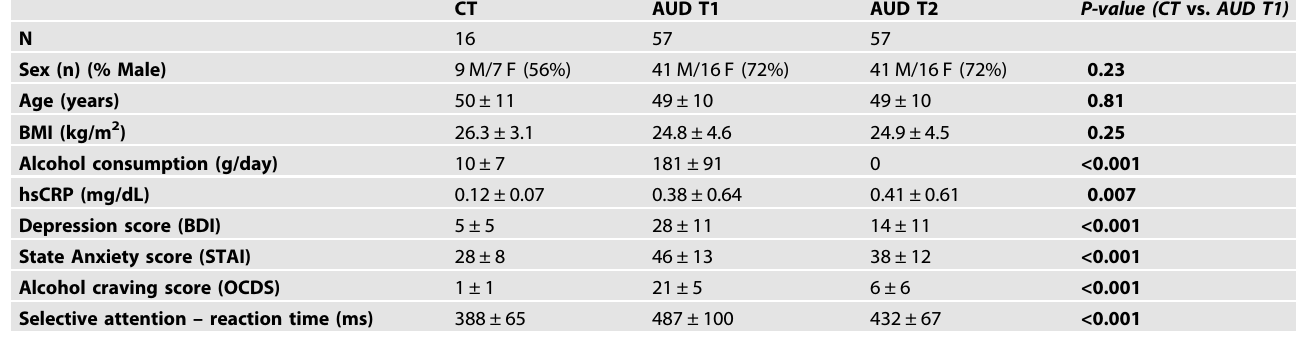
Table 1. Biological and psychological features of AUD patients and healthy controls.